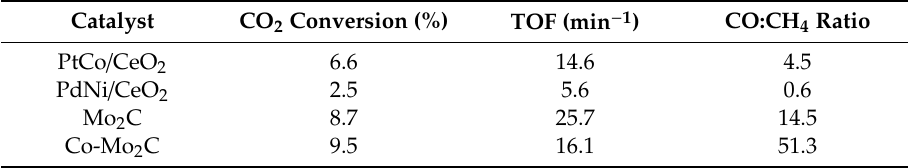
Table 2. Summary of conversion, turnover frequency (TOF) and selectivity of selected bimetallic catalysts, Mo 2 C and 7.5 wt % Co-Mo 2 C, adapted with permission from